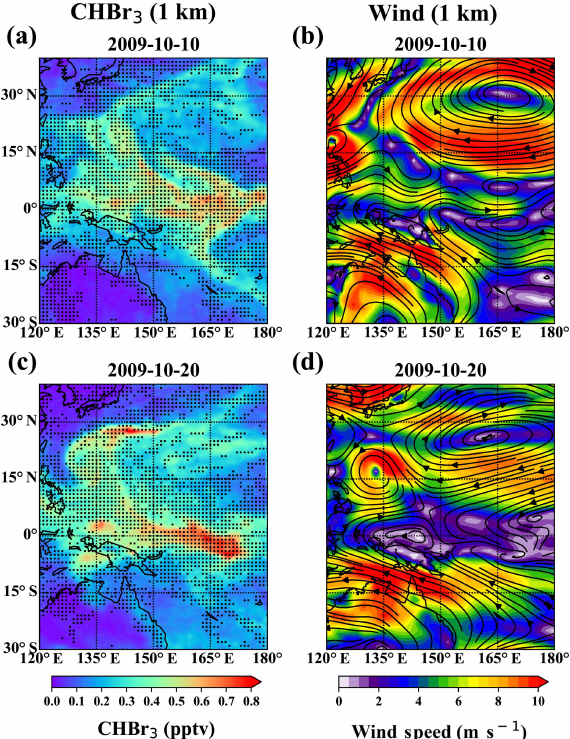
Figure 2. Two snapshots of spatial distributions of atmospheric CHBr 3 , derived from uniform oceanic background emissions of 100pmolm − 2 h − 1 (a, c) and ERA-Interim reanalysis wind fields (b, d) at 1km altitude during TransBrom. The wind speed is denoted by color shades and the directions are denoted by the stream lines. The regions of convergence are shaded in (a, c) .